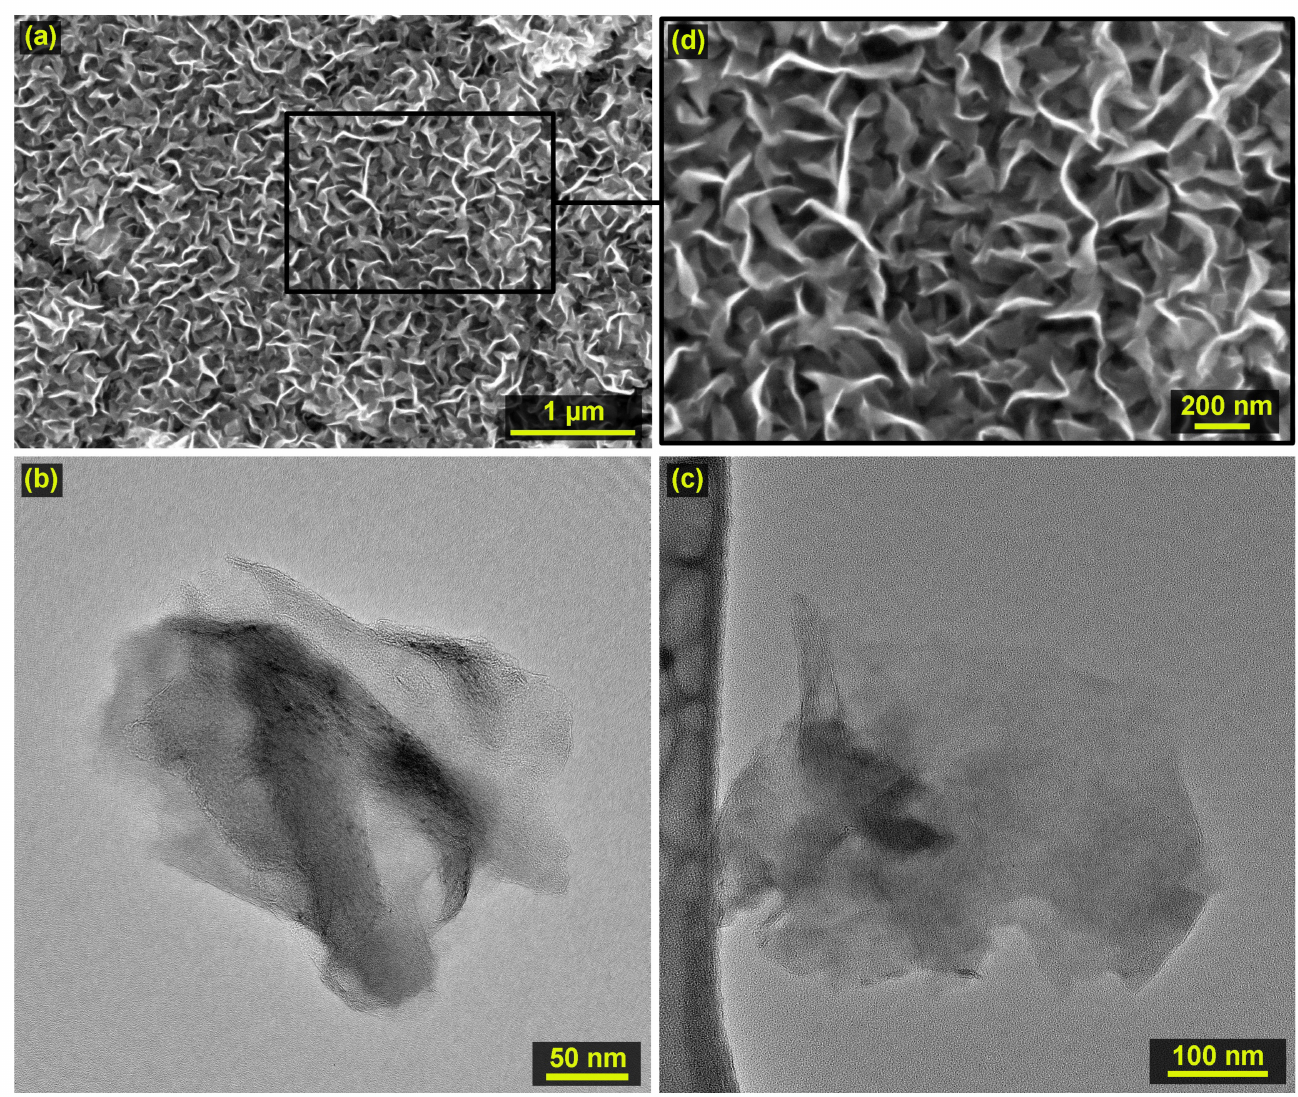
Figure 3. ( a ) an image of vertical graphene from Sample 50 (SEM/SE), ( b , c ) vertical graphene observed in TEM, ( d ) detail of picture ( a